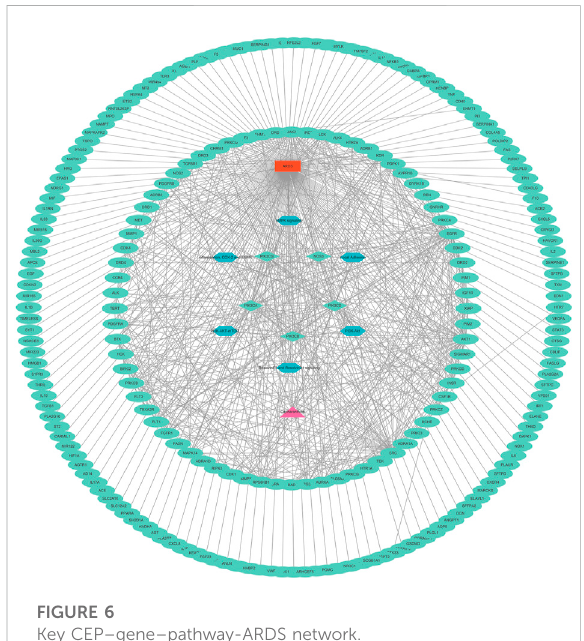
FIGURE 6 Key CEP – gene – pathway-ARDS